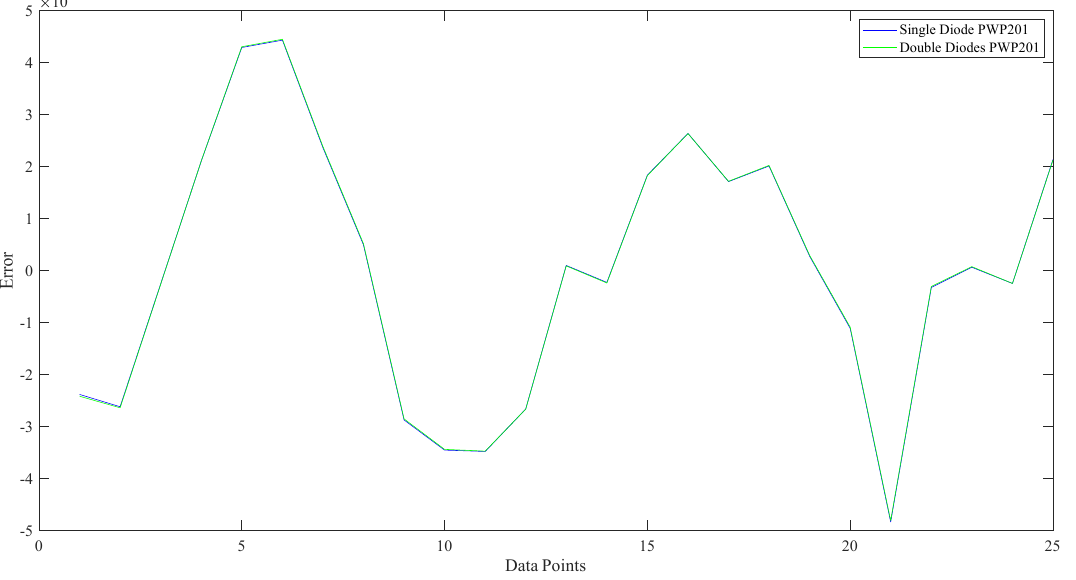
Figure 13. Error vs. data points for single diode and double diodes—PWP201 photovoltaic panel.